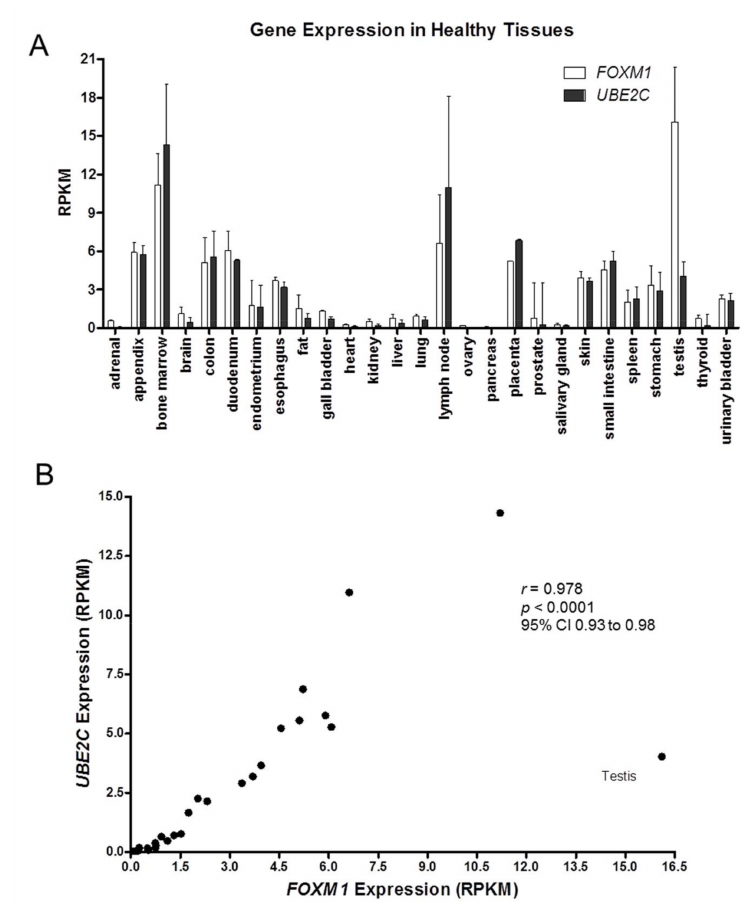
Figure 1. FOXM1 and UBE2C gene expressions are correlated in human healthy tissues: ( A ) FOXM1 and UBE2C show a similar expression profile in several distinct human healthy tissues; ( B ) Correlation analysis between FOXM1 and UBE2C expressions was performed using gene expression data of samples from 27 human healthy tissues using SRA data, bioproject PRJEB4337. Only testis showed